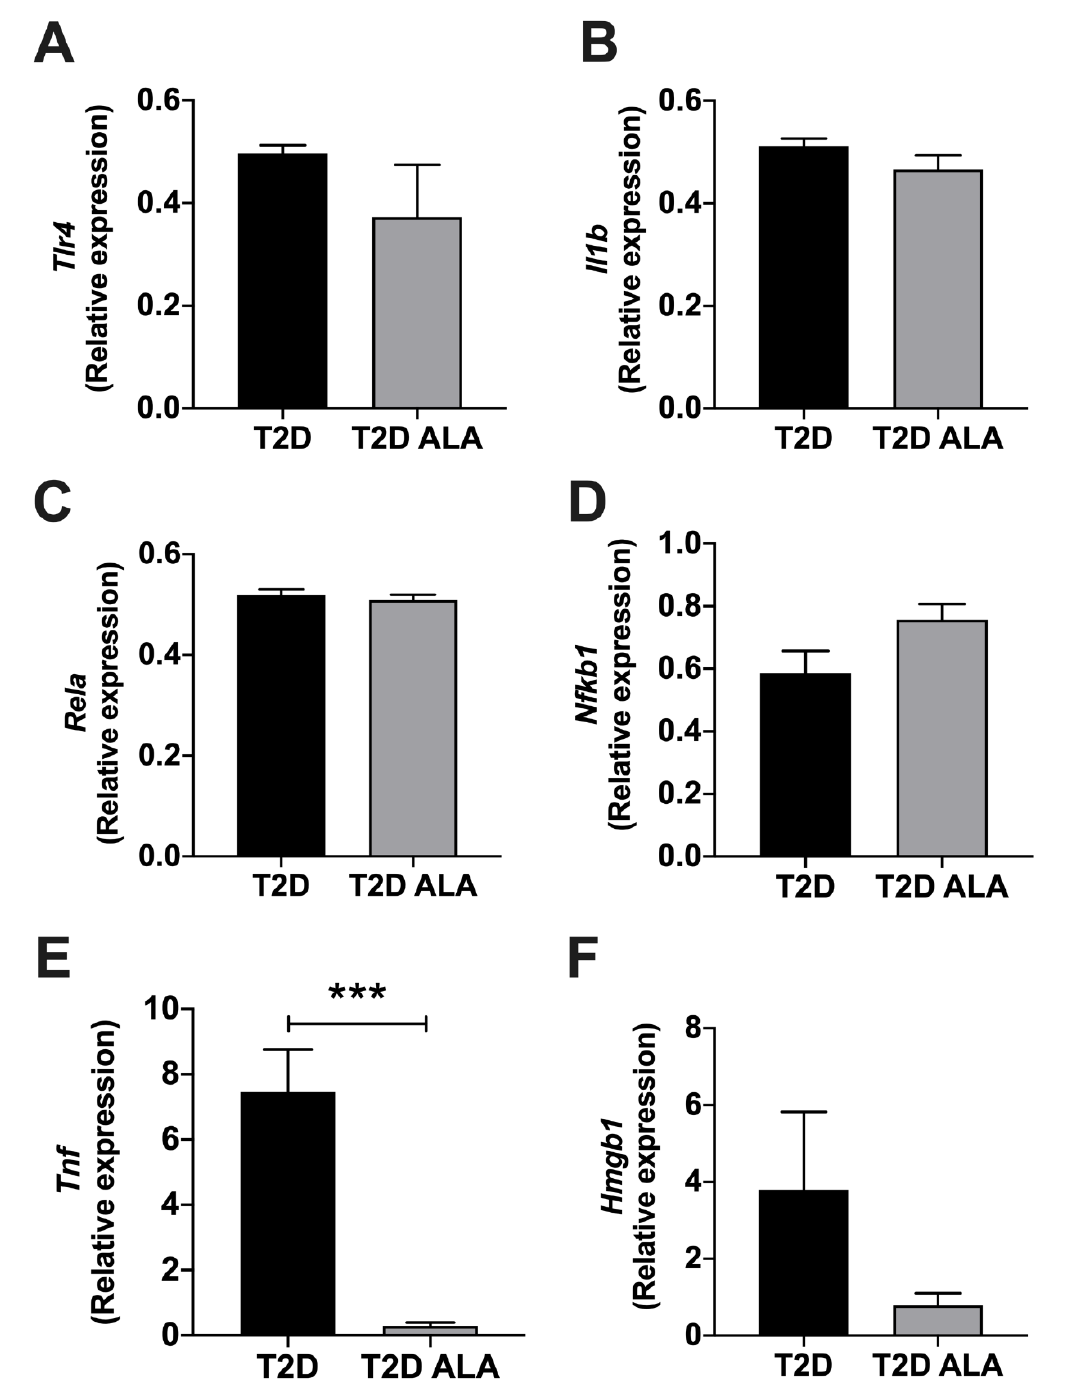
Figure 8. Inflammation related transcript expression in ventricular myocardium from T2D mice ± dietary ALA supplementation. Data are shown for gene expression as measured by real-time PCR in left ventricular tissue for ( A ) Tlr4 , ( B ) Il1b , ( C ) Rela , ( D ) Nfkb1 , ( E ) Tnf, and ( F ) Hmgb1 from ALA- supplemented compared to un-supplemented T2D mice. ΔΔC T values have been converted to 2 −ΔΔCT and presented as means±SEM ( n = 6/group). **, p <